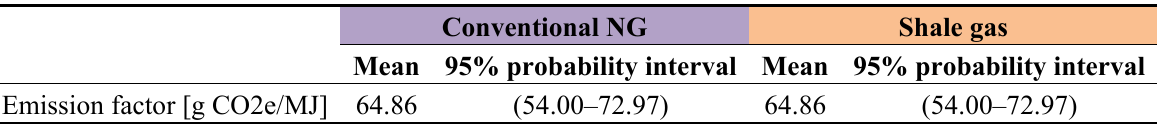
Table 4. Comparison of statistical results of emission factors derived from Monte Carlo simulation between conventional NG and shale gas. The 95% probability interval is shown in parentheses. Note that it is assumed that the mix of natural gas from conventional NG and shale gas creates the same GHG emission factor profile.